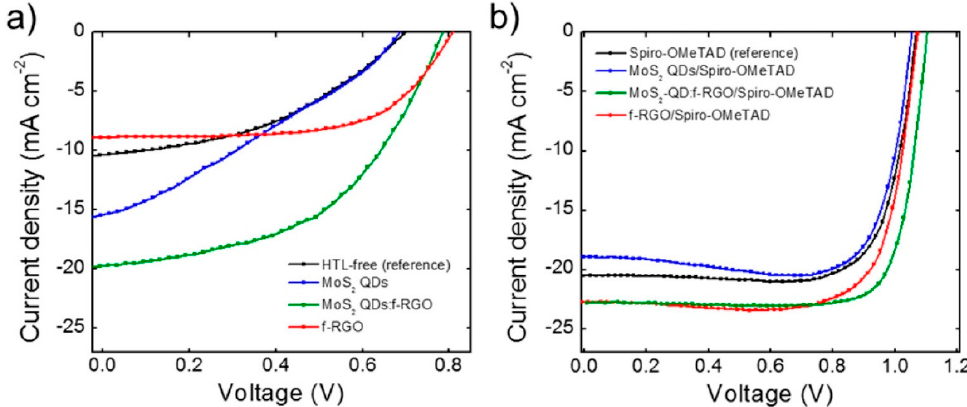
Figure 16. ( a , b ) I-V characteristics of tested PSCs using MoS 2 QDs, f-RGO, and MoS 2 QDs:f-RGO as HTL (panel a) or ABL between MAPbI 3 and spiro OMeTAD. Reproduced with permission from [82]. American Chemical Society, 2018. Hybrid structures-based phototransistors have been used to achieve high-performance optoelectronic devices. Ulganathan et al. fabricated a phototransistor with InSe nanosheets The organic cations used in PSCs are hygroscopic and have led to device instability. decorated with MoS 2 QDs (see Section 4.2.2) and used the device as the active layer in a solar cell [94]. A schematic representation of the device can be found in Figure 17. In this device, TiO 2 was used at the ETL, and 2,2 (cid:48) ,7,7 (cid:48) -tetrakis ( N,N-di-p-methoxyphenyl-amine ) 9,9 (cid:48)